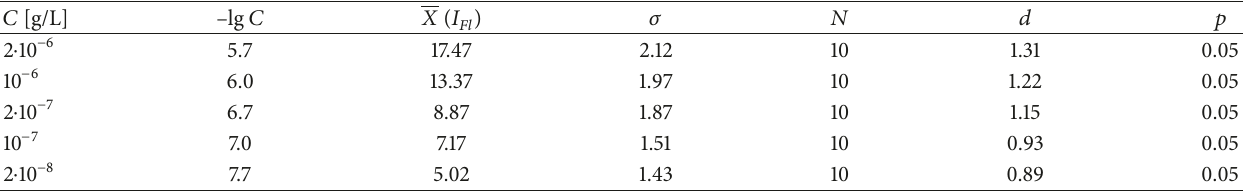
Table 3: Statistical processing of the experiment.